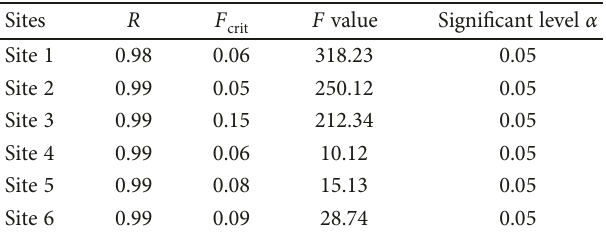
Figure 5: The scatter plots of actual and forecast global solar radiation by seven models: bold black dash line represents the perfect fi t. Table 10: The results of statistical analysis of selected variables by SREN at Sites 1 –